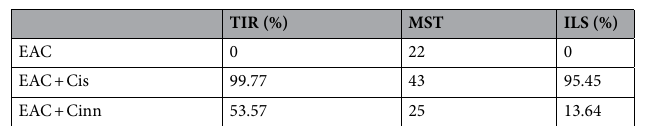
Table 3. The effect of cinnamon essential oil on the EAC-tumor burden and survival. Data were shown as mean ± SD, ( n = 3). EAC, Ehrlich ascites carcinoma; Cis, Cisplatin (2 mg/kg b.wt, i.p); Cinn, Cinnamon essential oil (50 mg/kg b.wt/day, orally). Significant differences ( P < 0.05) between groups were shown by different letters. TIR, tumor inhibition rate; MST, mean survival time; ILS, increase in life span.